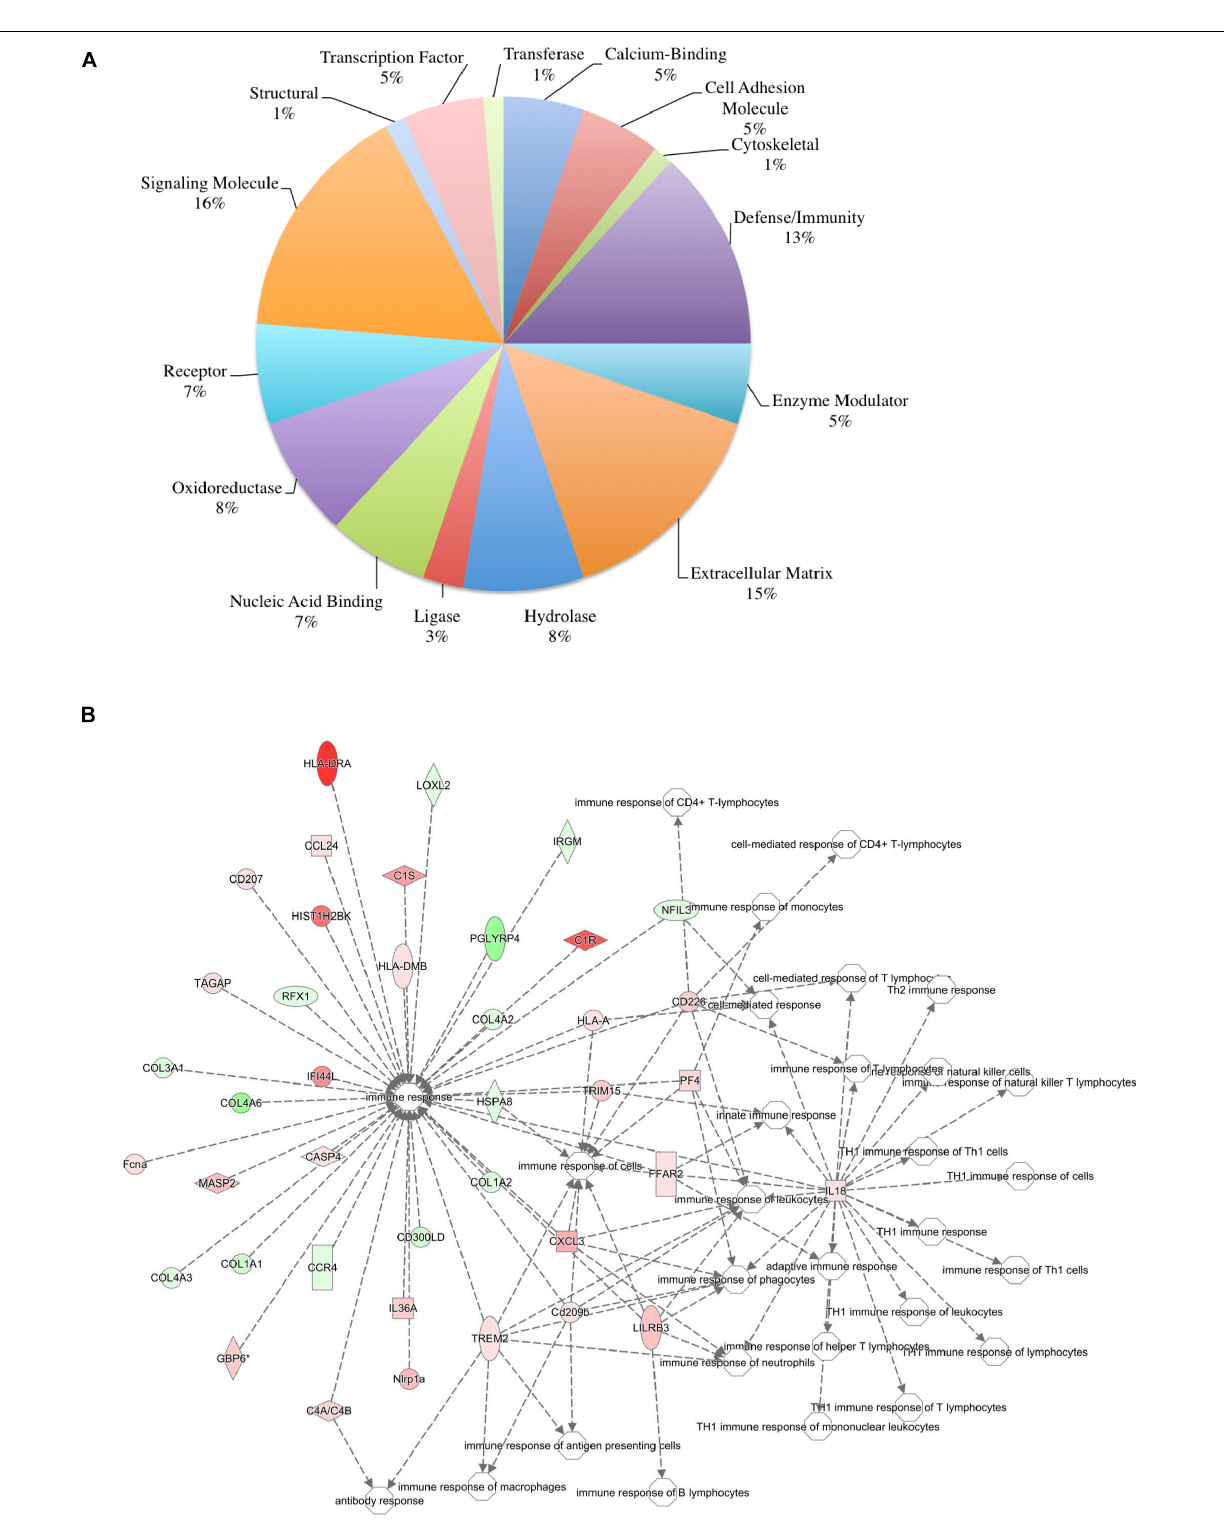
Frontiers in Microbiology |